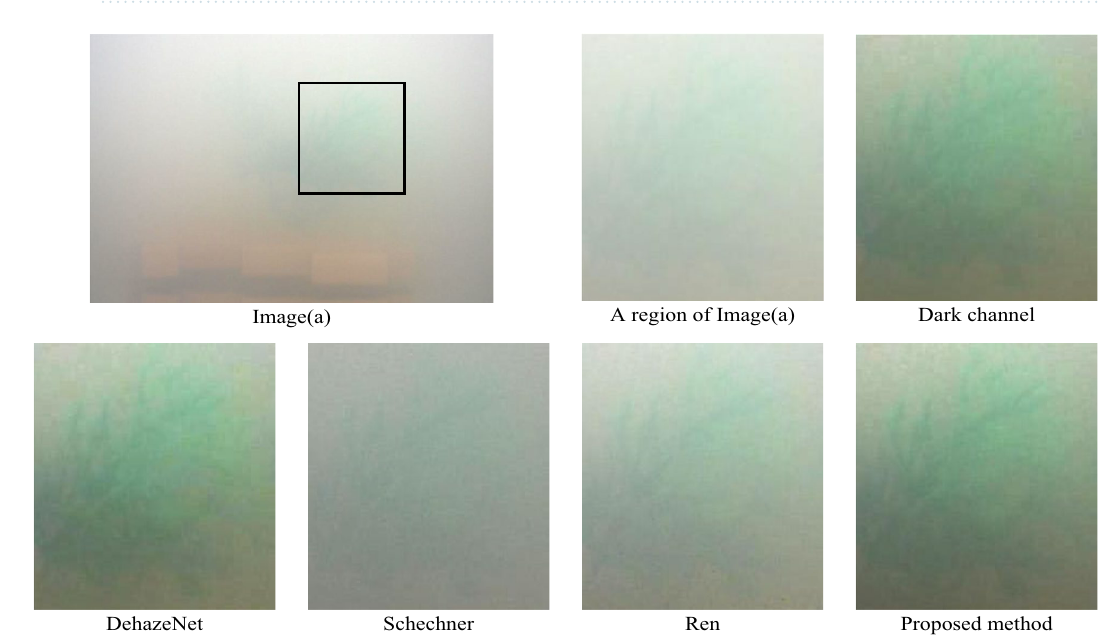
Figure 8. The same region in images ( a ), ( d ), ( e ), ( f ) in group